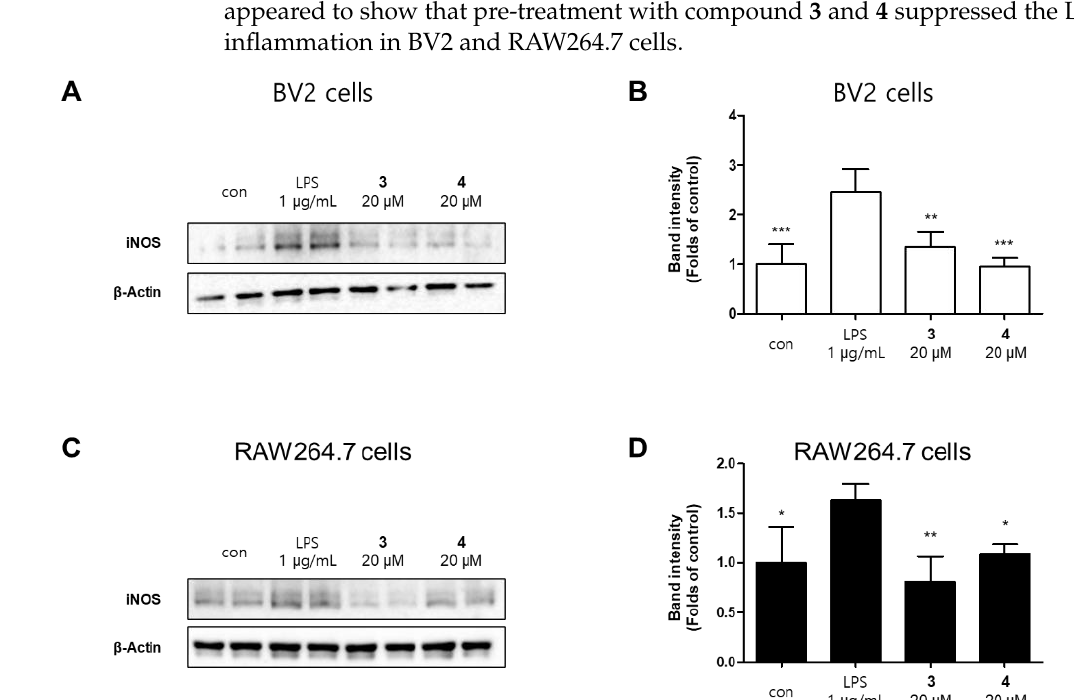
Figure 4. Protein expression levels of inducible nitric oxide synthase (iNOS) in lipopolysaccharide (LPS)-stimulated BV2 ( A ) and RAW264.7 ( C ) cells. The cells were pretreated for 2 h with various concentrations of compounds 3 or 4 and stimulated for 24 h with LPS (1 μg/mL). Representative blots from three independent experiments are shown. Immunoblots were quantified using the ImageJ software. Band intensities are normalized to that of β -actin ( B , D ). Error bars represent mean ± standard deviation of three independent experiments. * p < 0.05, ** p < 0.01, and *** p < 0.001 compared with the LPS-treated group.